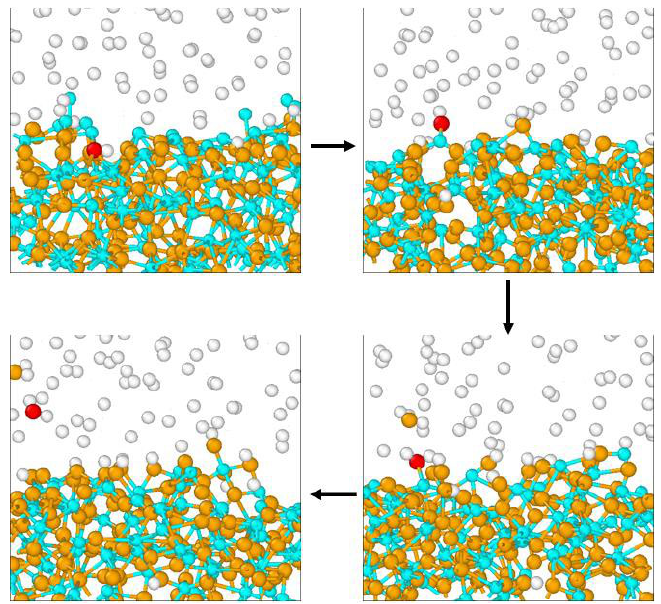
Figure 3. Schematic diagram of O and H combination process. (Hydrogen chloride corrodes iron oxide, red is marked oxygen, the rest of oxygen is yellow, white is hydrogen, aqua is iron, chlorine is not shown.)